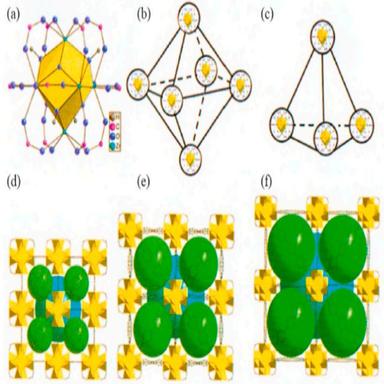
Schematic example of UiO structure when (a) is secondary building unit, (b) is octahedral cage, (c) is tetrahedral cage, (d) is UiO-66, (e) is UiO-67, and (f) is UiO-68.